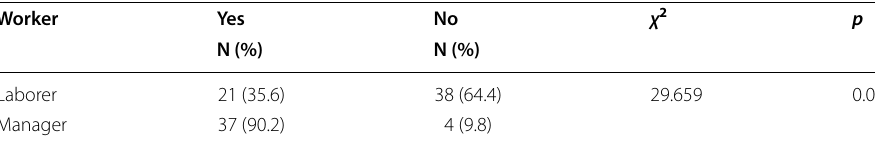
Table 6 Workers who wear workwear Worker